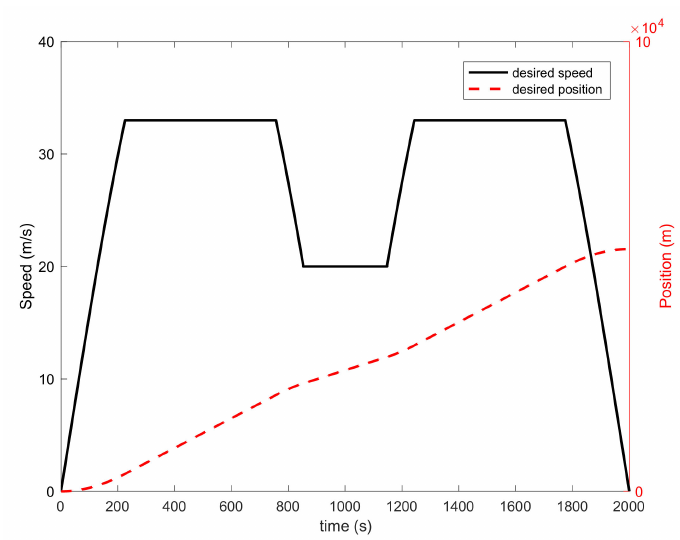
Figure 3. Desired speed and position profiles of train